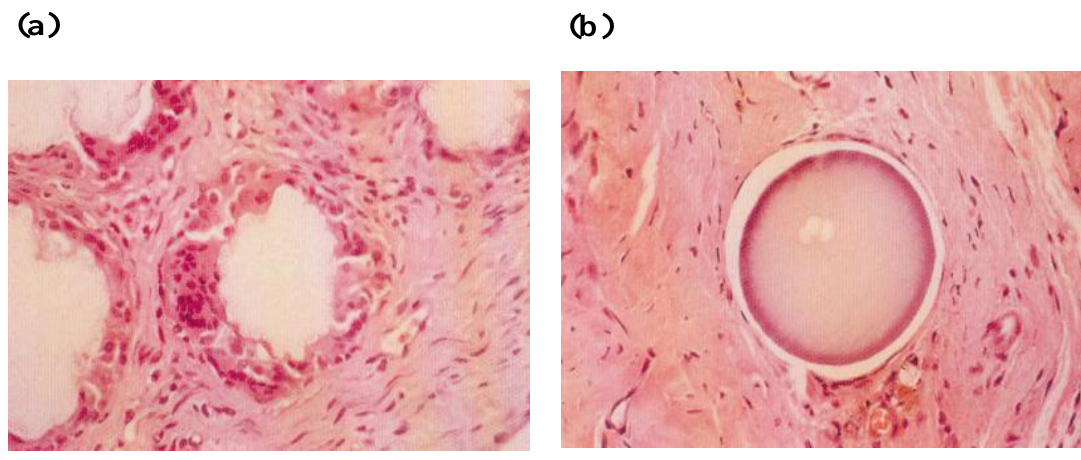
Figure 2. Histological appearance of the implant material particles and the surrounding tissue in rabbits knee joint. (×100) (a) UHMWPE particle: many macrophage and giant cells are surrounding particle due to intense foreign-body reactions. (b) PVA-H particle: foreign-body reactions were hardly